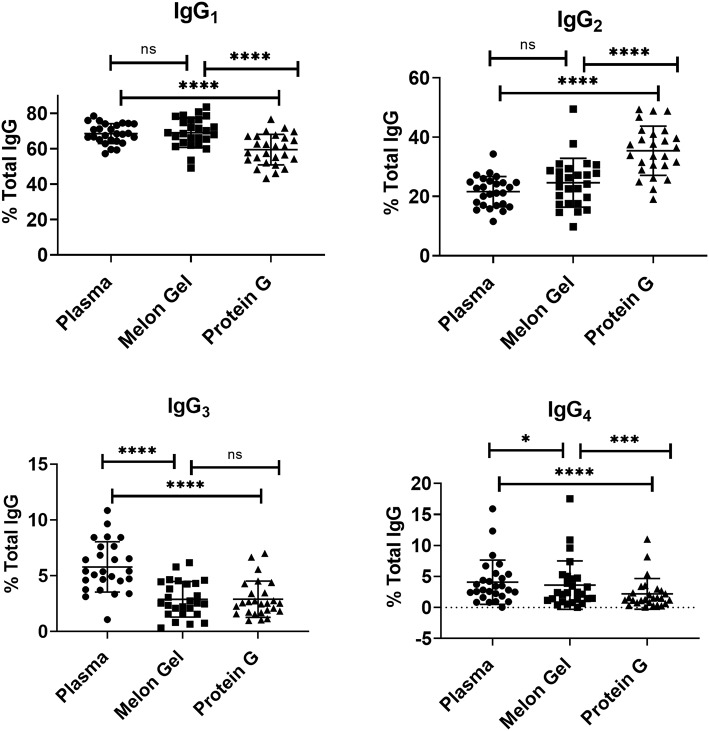
Mean and SD of subclass percentage obtained for plasma and purified (Melon Gel and Protein G) IgG samples (n = 26) via Multiplex immunoassay. The Friedman test with Dunn's multiple comparisons was used to compare data from each group. *p ≤ 0.05; ***p ≤ 0.001; ****p ≤ 0.0001.